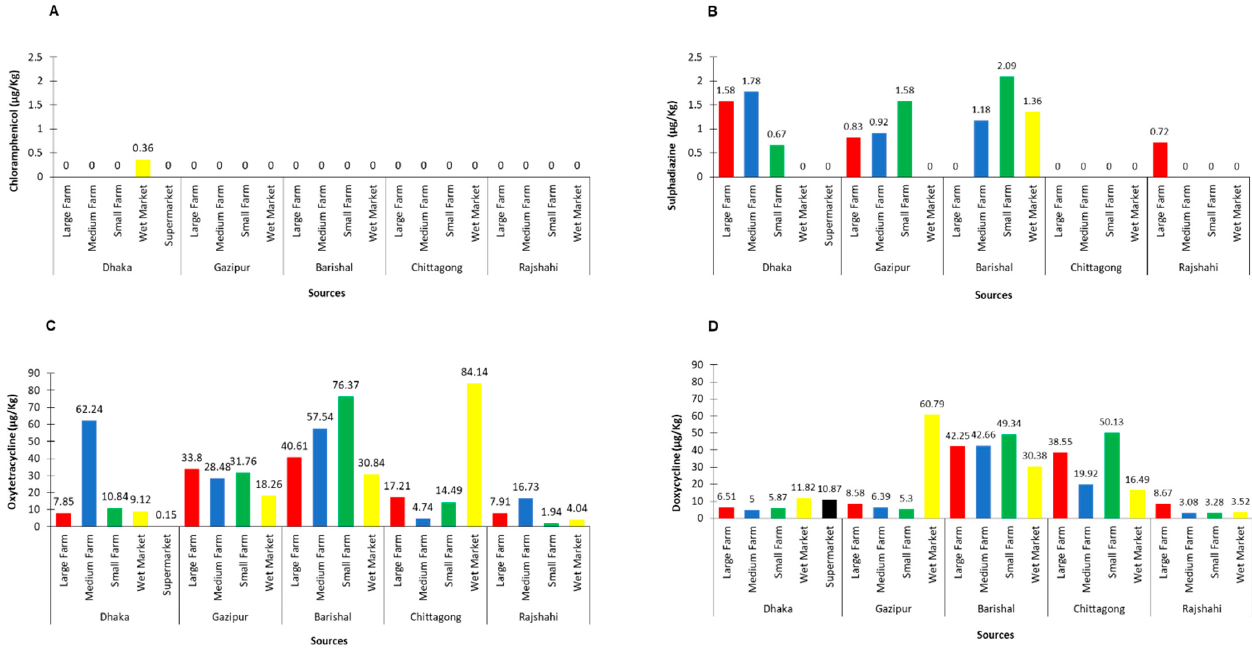
Figure 5. Concentration of antimicrobial residues. ( A ) Chloramphenicol, ( B ) sulphadimidine, ( C ) oxytetracycline, ( D ) doxycycline in broiler meat, bone and edible composite collected from various large farms, medium farms, small farms, broiler wet meat markets and supermarkets of the Dhaka